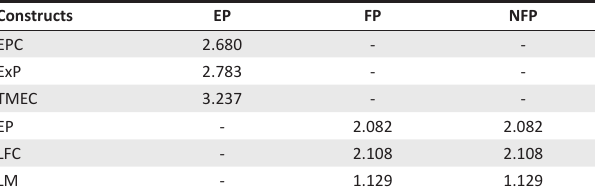
TABLE 8: Output of variance inflation factor test. Constructs